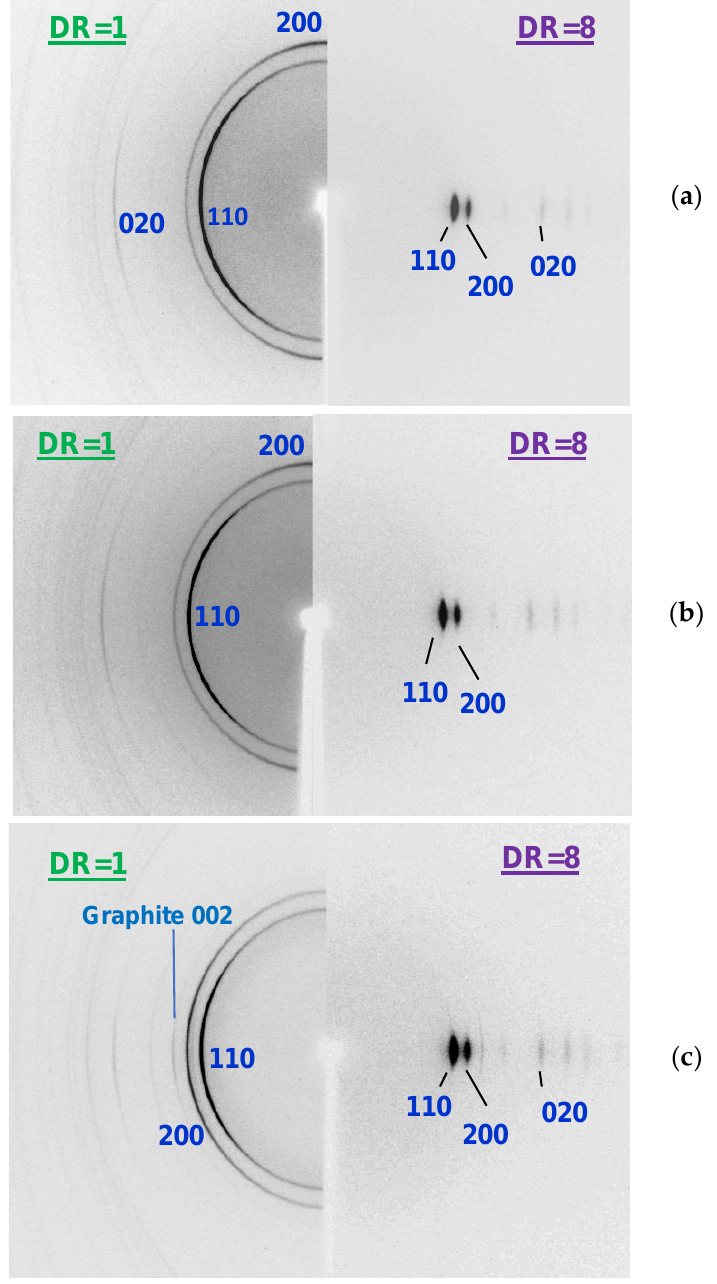
Figure 9. X-ray 2D-patterns of the polyethylene-based fibers before (DR = 1) and after orientational drawing (DR = 8): ( a ) pure HDPE; ( b ) HDPE + 5 wt. % oND; ( c ) HDPE + 5 wt. % aND. The fiber axis was vertical.